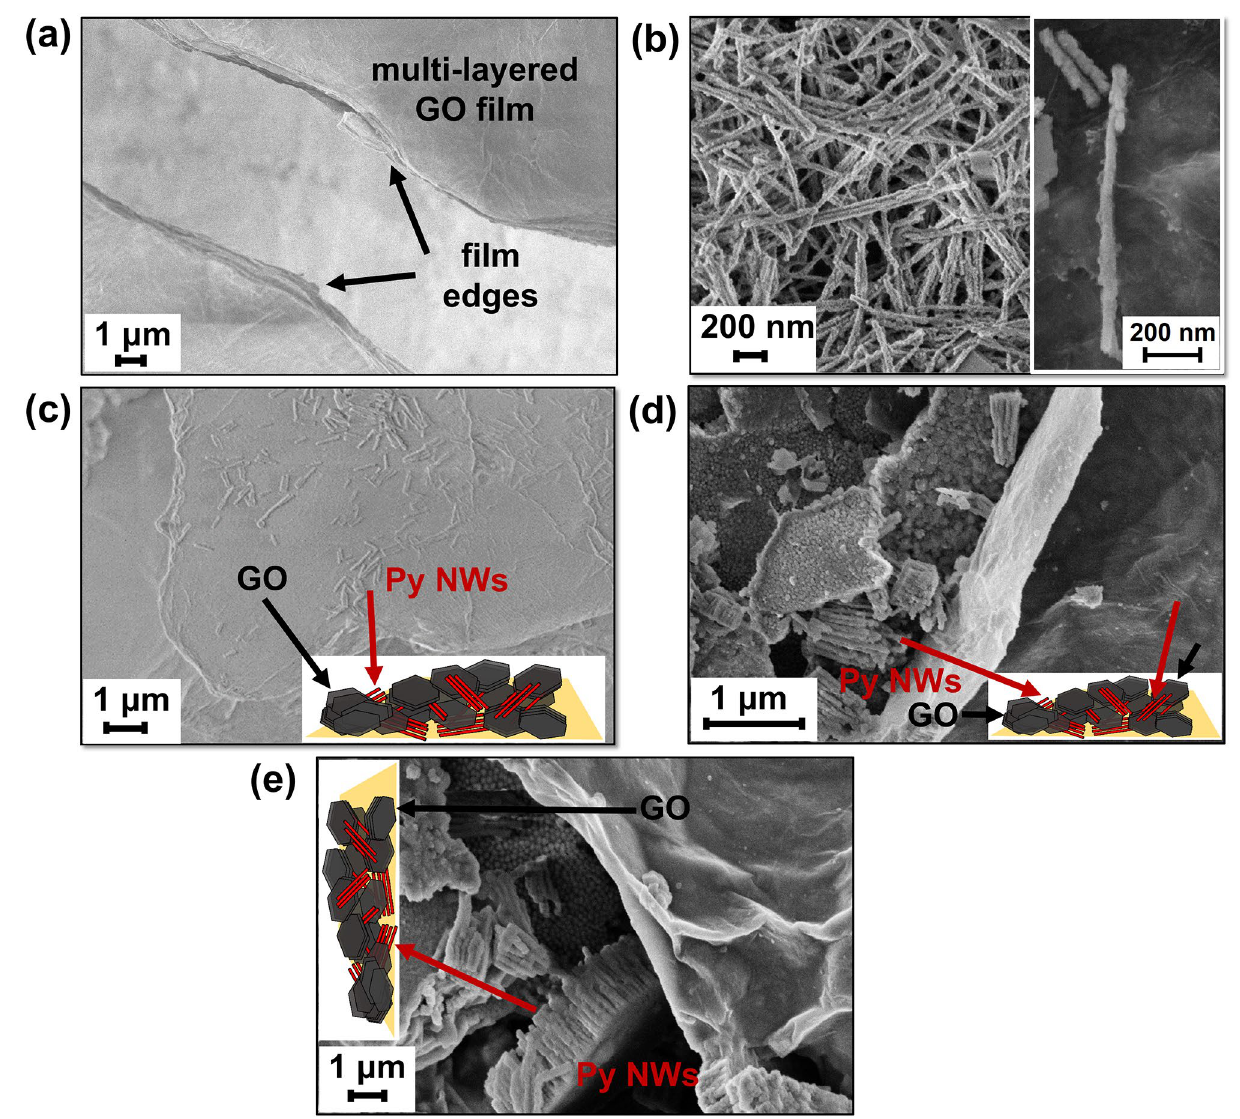
Figure 1. SEM images of ( a ) GO thick films, ( b ) decoupled Py NWs, and ( c ), ( d ) and ( e ) different views of the Py NWs/GO composites, including schemes as guides to the eye for an easier recognition of each composite component. Inset in ( b ): representative isolated Py NWs decoupled from AAO